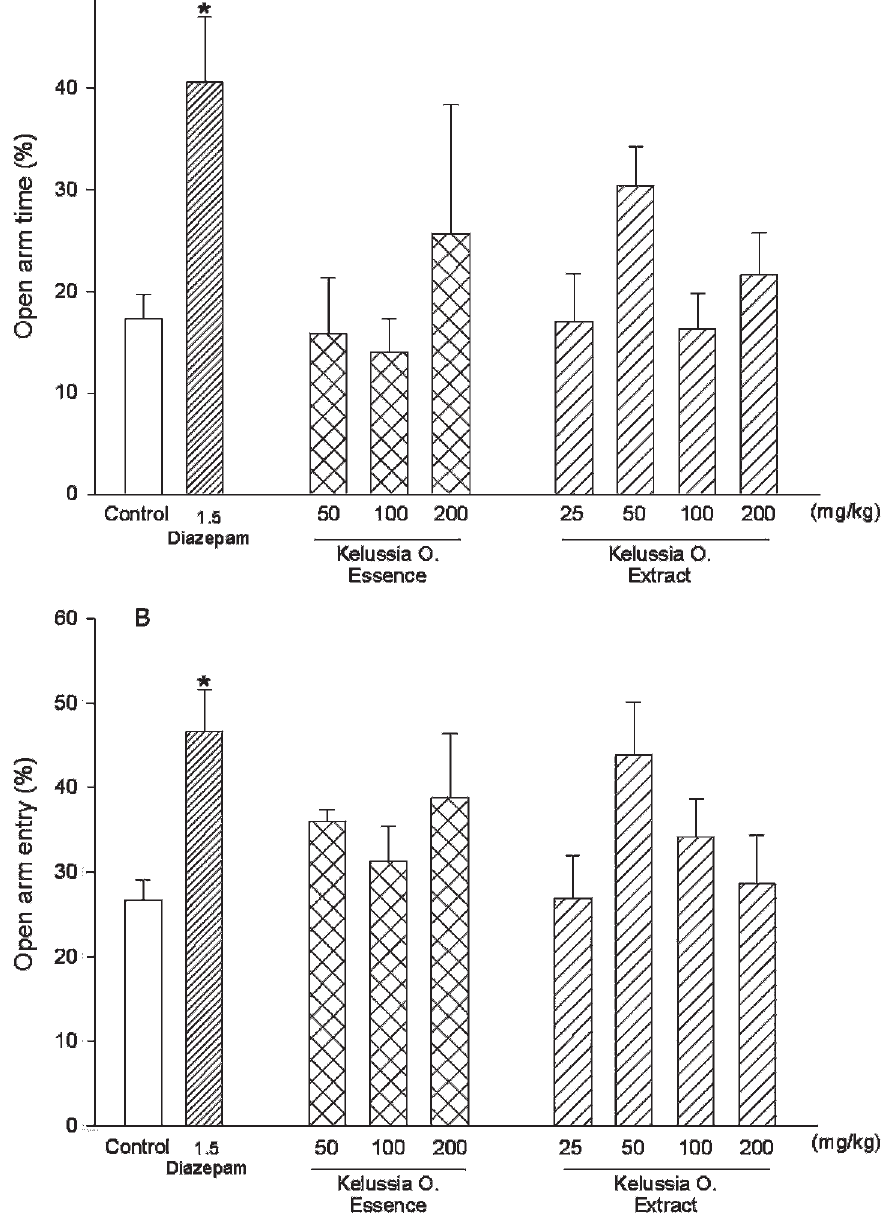
Figure 1 - The effects of diazepam, vehicle and different doses of K. odoratissima essential oil and extract on (A) the percentage of time mice spent in the open arms and on (B) the percentage of entries into the open arms during a 5-min test. Various doses of the plant’s essential oil or extract, diazepam or vehicle were injected 30 min prior to testing. Data are presented as mean values ¡ SEM for each group of 6 mice. * p , 0.05 compared to